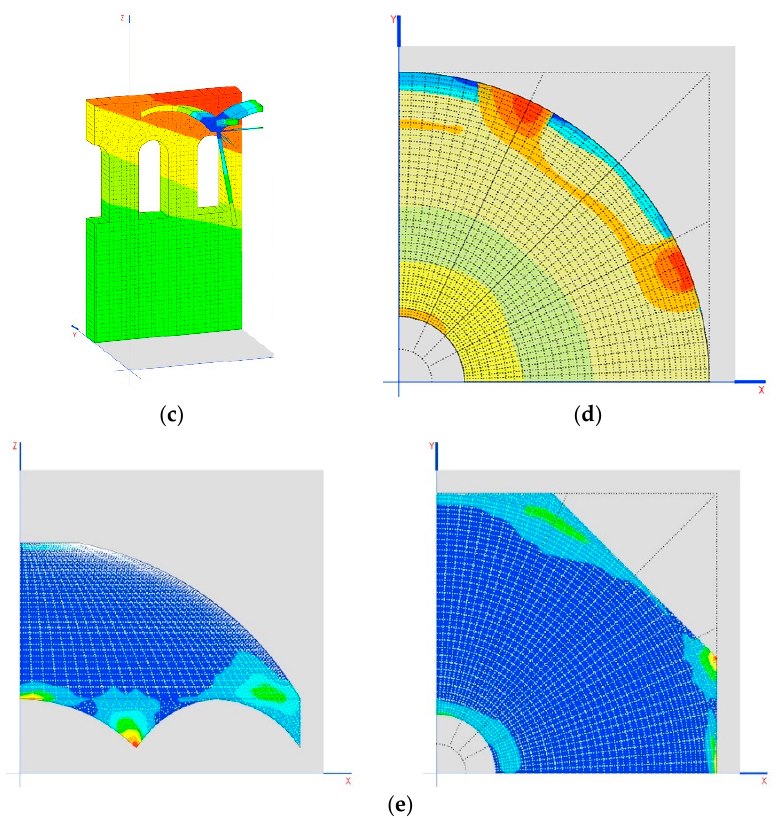
Figure 14. ( a ) Displacement in Z of the building; ( b ) detail of the dome and its deformation (the blue zone is the one supported on the wall, the green zone is the one supported on the gallery); ( c ) displacement in Y of the wall in mm (perpendicular to its plane); ( d ) main directions of stresses in the dome; ( e ) tension peaks in the intersection of the arches.